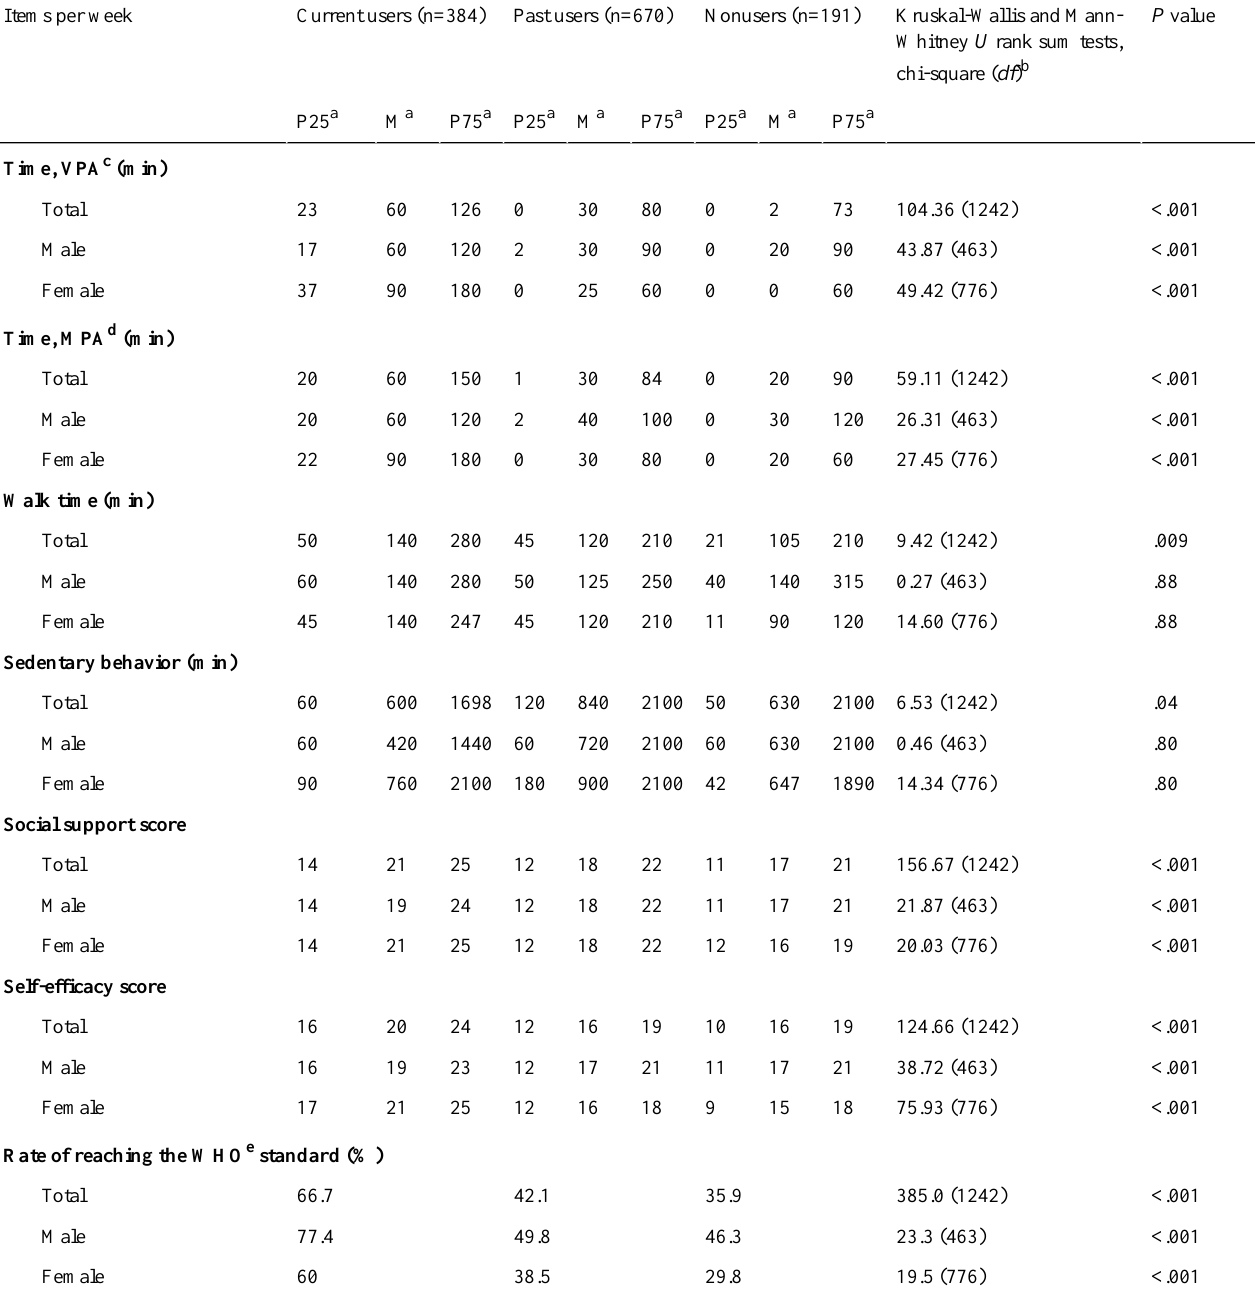
Table 2. Differences between current users, past users, and nonusers.